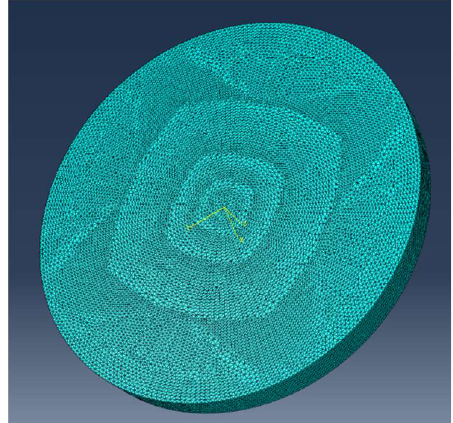
Figure 6. Schematic diagram of the reflector